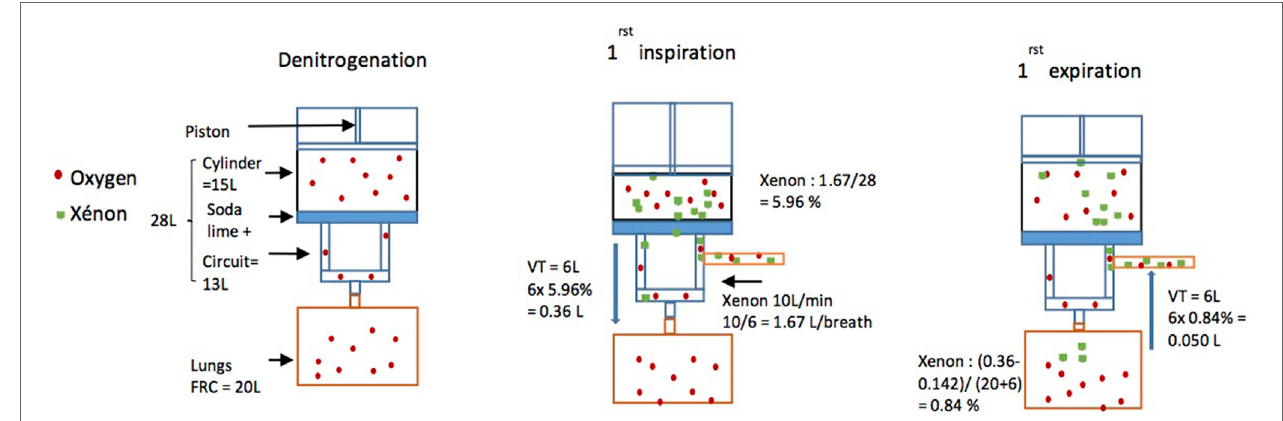
FigUre 2 | Schematics of the modeling of gas movements. During the denitrogenation phase, xenon flow was turned off. Then xenon flow was started at 10 L min − 1 . As f R was six breaths per minute during the experiment 10 L/6 = 1.67 L of xenon were delivered from the bottle into the machine for each breath. Just before the first breath, as the total volume of the machine was 28 L, the total percentage of xenon in the machine was 1.67 L/28 L = 5.96%. So, when the horse breathed xenon for the first time, as the tidal volume (TV) was 6 L, the horse breathed 6 L × 5.96% = 0.36 L of xenon (Vol Xe insp). The horse’s consumption was assumed to be 0.1 L kg − 1 h − 1 ( = 0.142 L per breath). The new percentage of xenon in the horse’s lungs was then the amount breathed in less the amount consumed, divided by the total volume of the lungs (FRC + TV) so (0.36 − 0.142)/(20 + 6) = 0.84%. Then, as the horse breathed out 6 L containing 0.84% of xenon back into the machine, 6 L × 0.84% = 0.05 L of xenon were expired back into the machine (Vol Xe